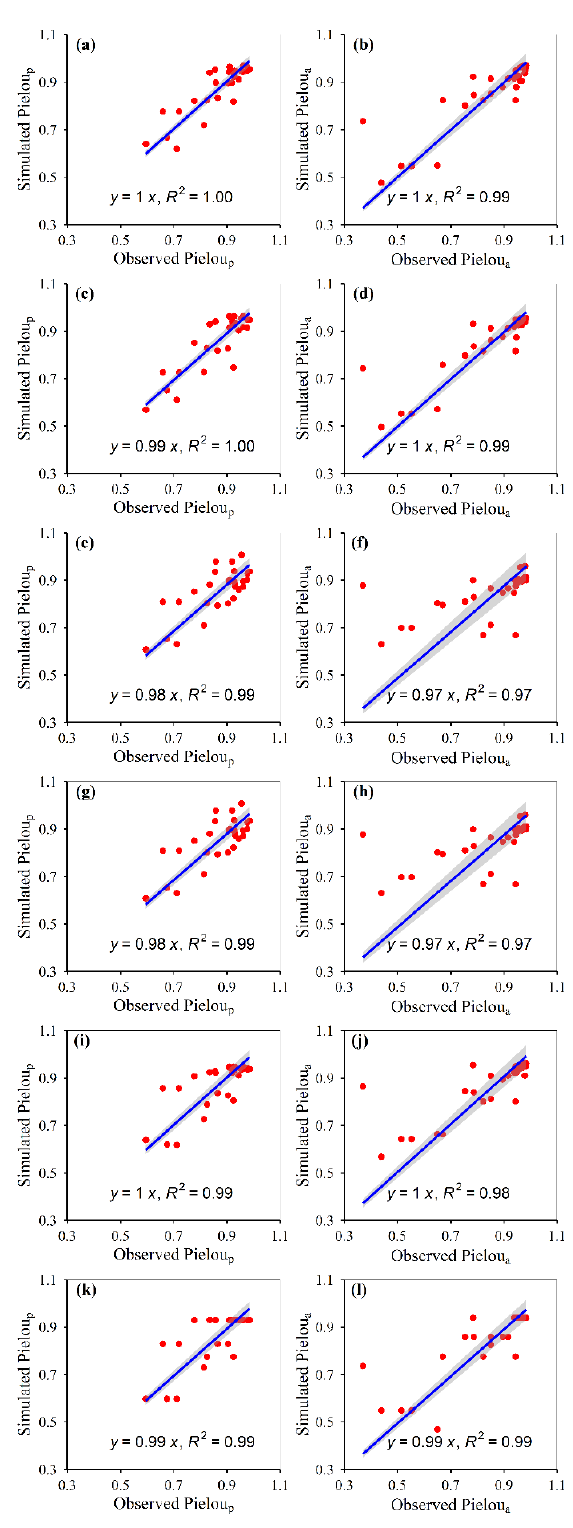
chines ( i , j ) and recursive regression trees ( k , l ). The solid lines indicate the linear fitted lines between the simulated and observed Simpson . Simpson p : potential Simpson; Simpson a : actual Simpson. All the regressions were significant at p < 0.001.